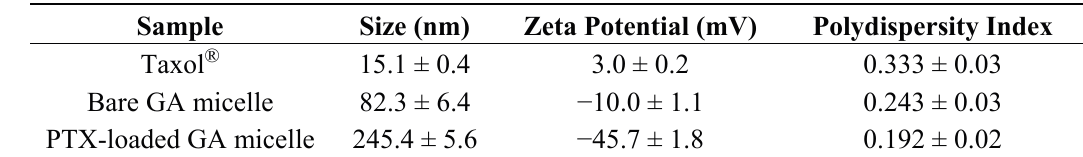
Table 1. Particle sizes, Zeta potential and polydispersity index values of the test micelles ( n =